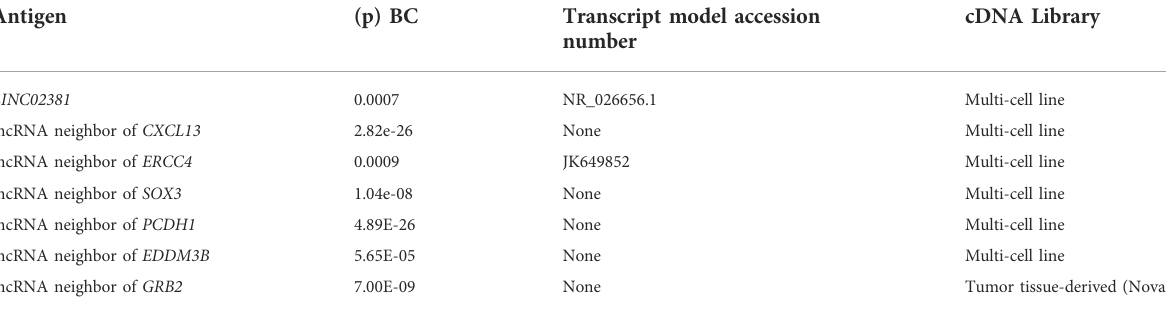
TABLE 2 LncRNA antigens associated with the diagnosis of invasive breast